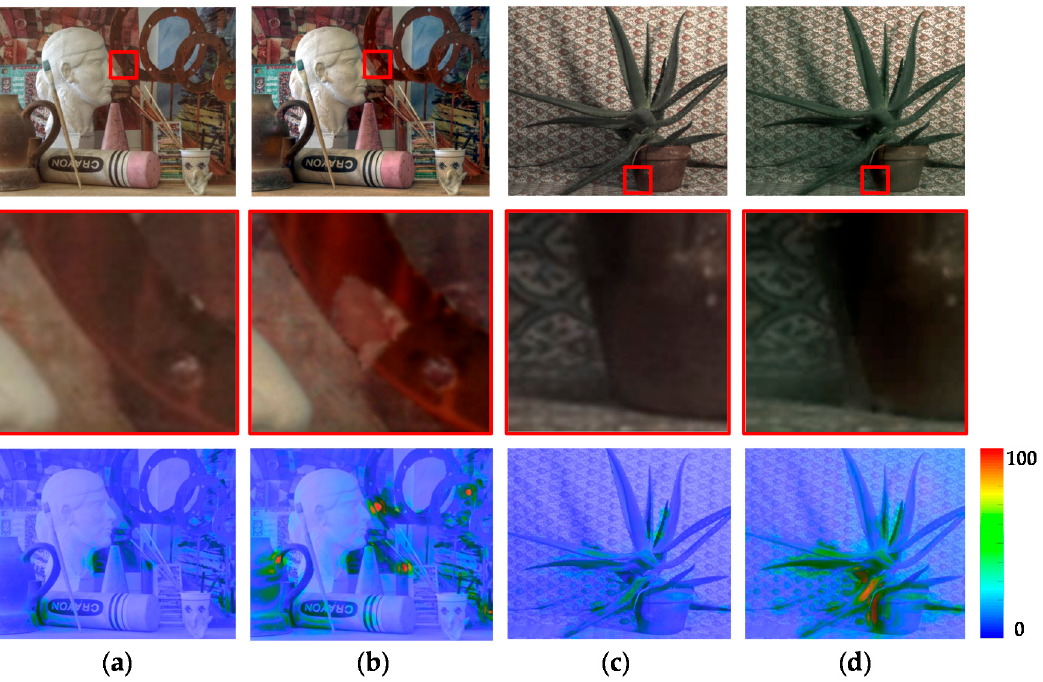
Figure 21. Resultant LDR images (first row) and their magnified sub-regions (second row) obtained with the two different ICRF estimation methods: ( a , c ) proposed ICRF estimation; and ( b , d ) conventional ICRF estimation [14]. Color-coded HDR-VDP2 maps (last row) are provided for a better performance comparison.